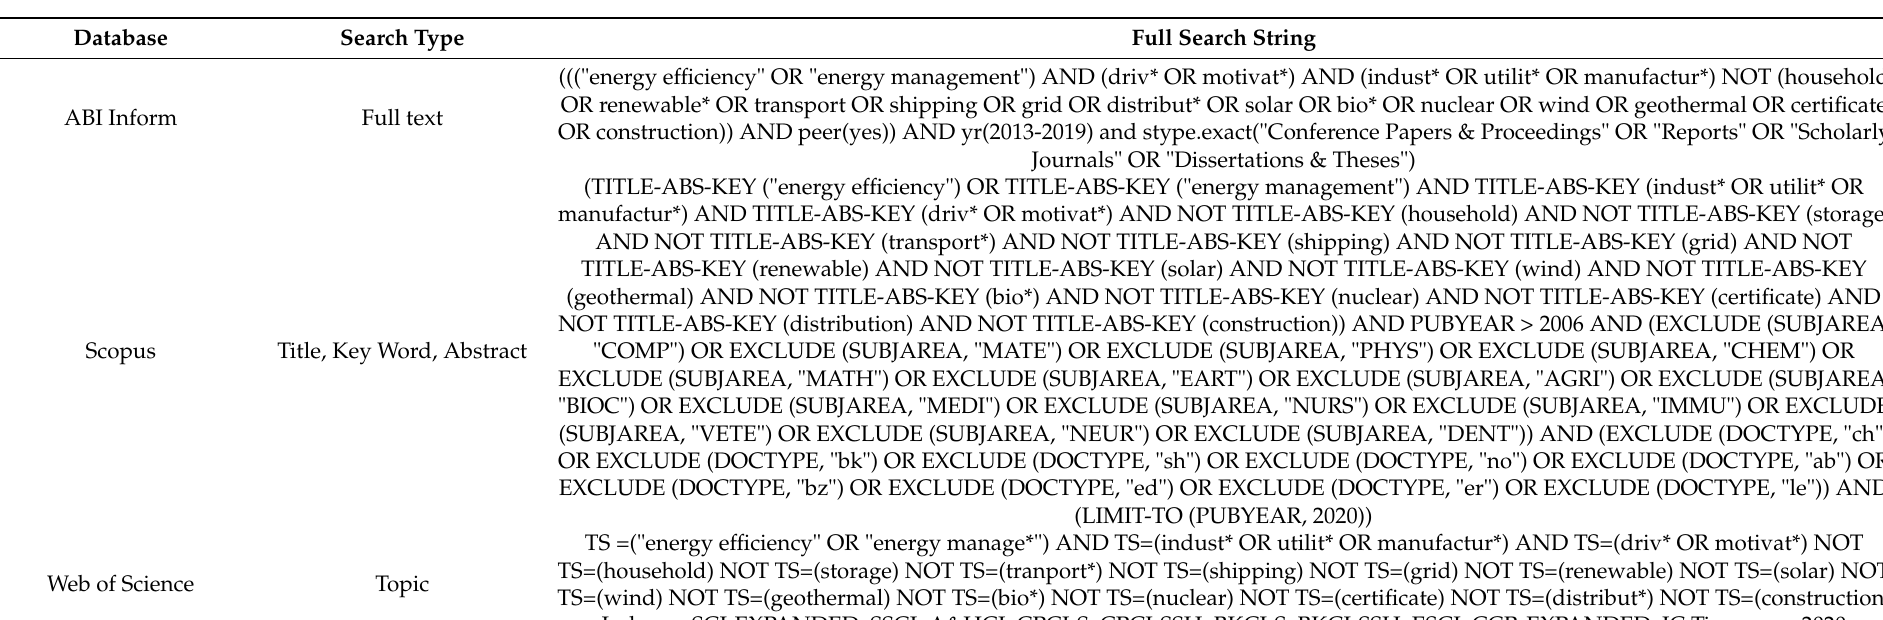
Table A1. Full search strings for each database. The asterisk (*) represents a wilde card in the search string.